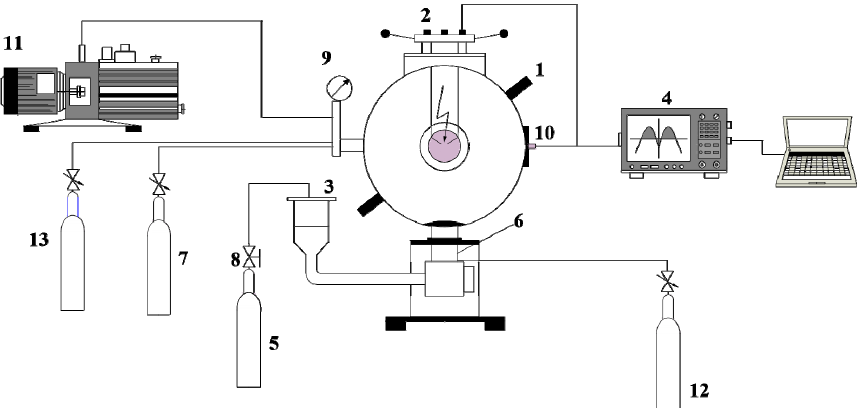
Figure 1. The illustration of 20 L spherical explosion test system. 1 —Circulating water export;